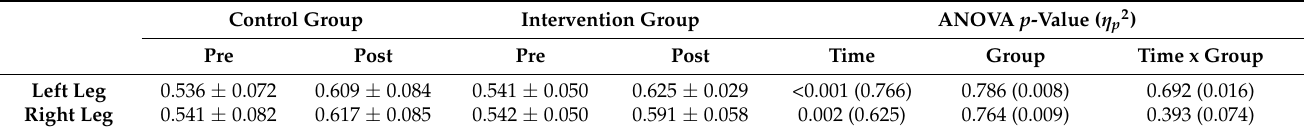
Table 3. MANOVA test comparing pre and post-intervention in both